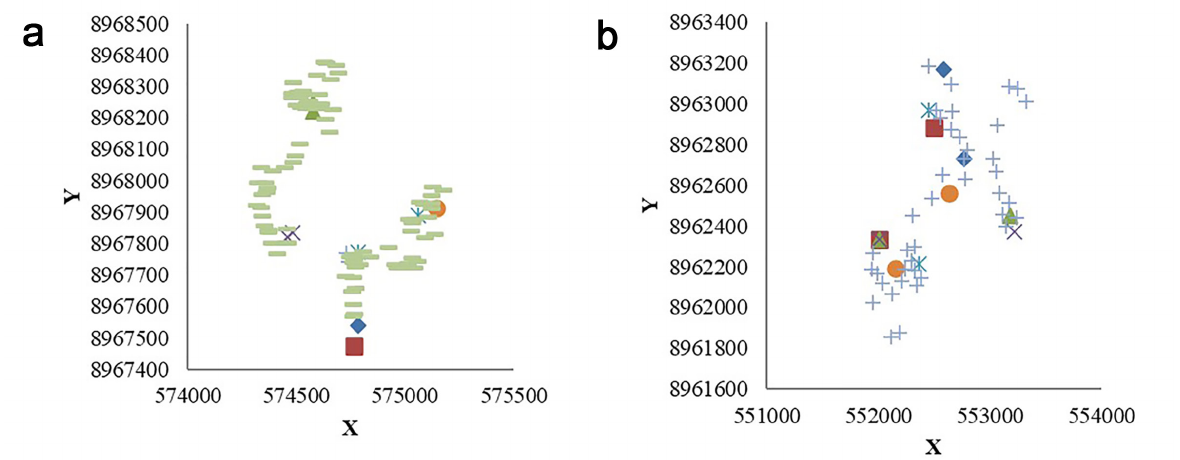
Figure 7. Geographic distribution of clonal individuals within populations 1 (a) and 2 (b) of Guadua aff. chaparensis . The Y and X axes represent the geographical coordinates; (a) the light-green dots (–) represent the non-clonal individuals (b) the light-blue dots (+) represent non-clonal